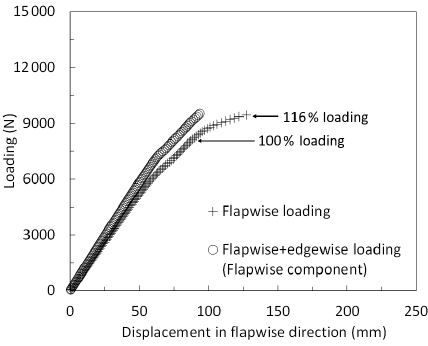
Figure 28. Load–displacement curves of the blade under pure flap- wise and combined loading using flapwise components of the load and